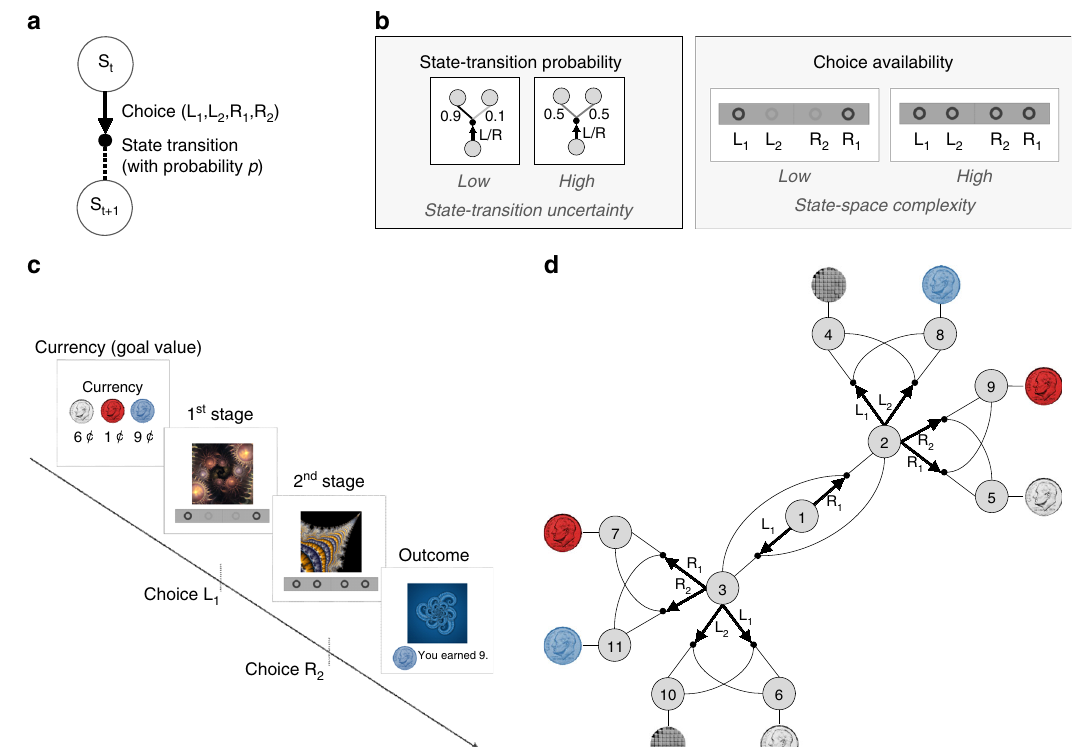
Fig. 1 Task design. a Two-stage Markov decision task. Participants choose between two to four options, followed by a transition according to a certain state-transition probability p , resulting in participants moving from one state to the other. The probability of successful transitions to a desired state is proportional to the estimation accuracy of the state-transition probability, and it is constrained by the entropy of the true probability distribution of the state-transition. For example, the probability of a successful transition to a desired state cannot exceed 0.5 if p = (0.5, 0.5) (the highest entropy case). b Illustration of experimental conditions. (Left box) A low and high state-transition uncertainty condition corresponds to the state-transition probability p = (0.9, 0.1) and (0.5, 0.5), respectively. (Right box) The low and high state-space complexity condition corresponds to the case where two and four choices are available, respectively. In the fi rst state, only two choices are always available, in the following state, two or four options are available depending on the complexity condition. c Participants make two sequential choices in order to obtain different colored tokens (silver, blue, and red) whose values change over trials. On each trial, participants are informed of the “ currency ” , i.e. the current values of each token. In each of the subsequent two states (represented by fractal images), they make a choice by pressing one of available buttons (L1, L2, R1, R2). Choice availability information is shown at the bottom of the screen; bold and light gray circles indicate available and unavailable choices, respectively. d Illustration of the task. Each gray circle indicates a state. Bold arrows and lines indicate participants ’ choices and subsequent state-transition according to the state-transition probability, respectively. Each outcome state (state 4 – 11) is associated with a reward (colored tokens or no token represented by a gray mosaic image). The reward probability is